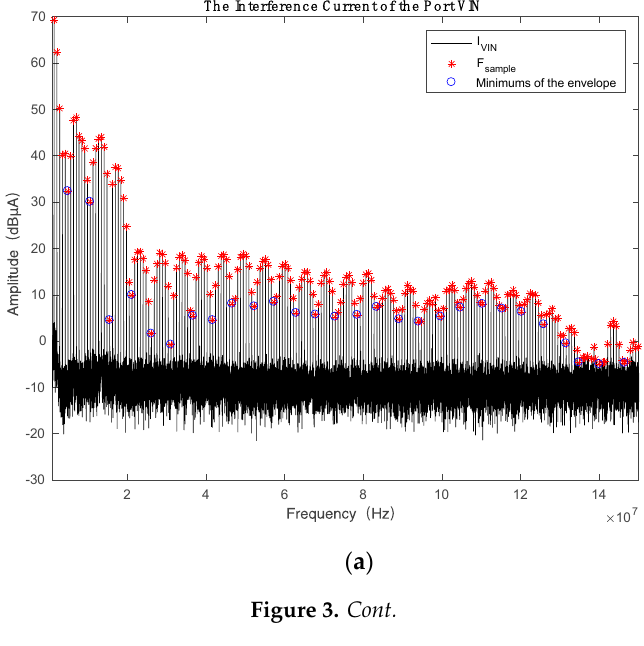
Figure 2. Experimental scenario of the test board at ( a ) VIN port; ( b ) VOUT port conduction emissions.